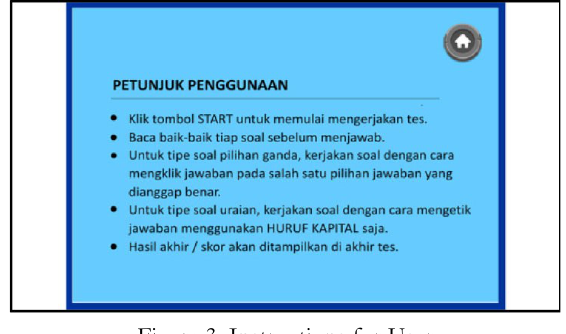
Figure 3. Instructions for User